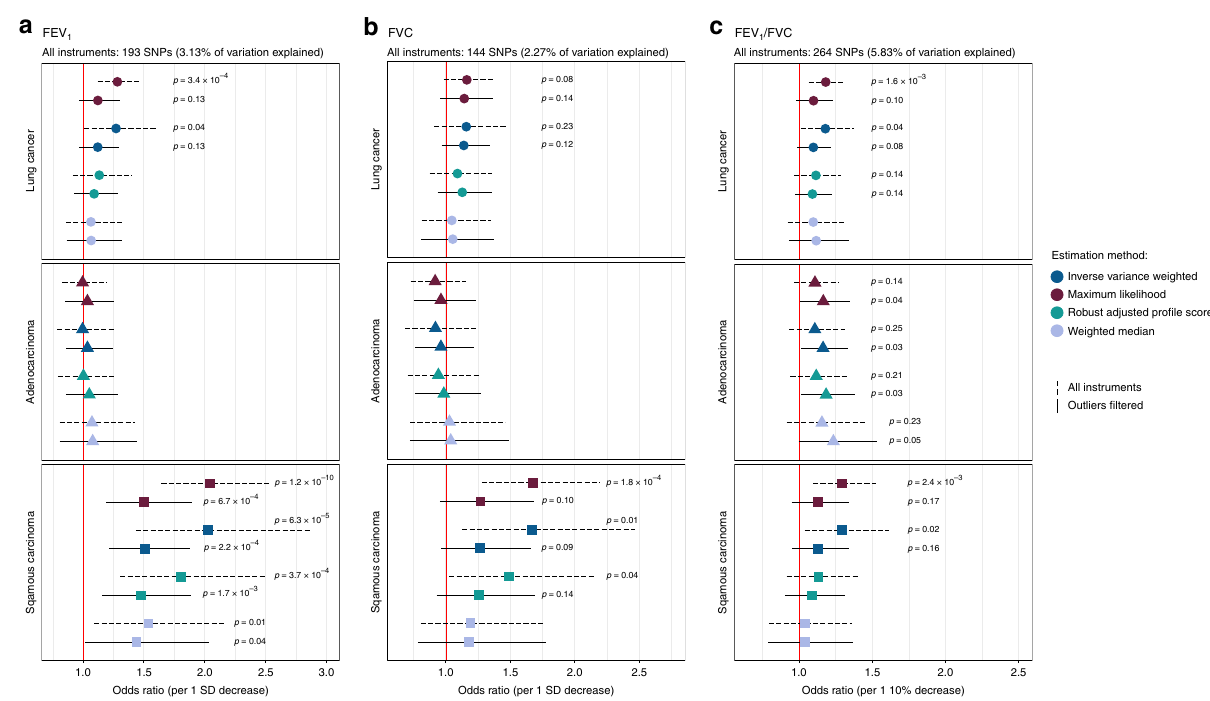
Fig. 4 Odds ratios (OR) and 95% con fi dence intervals for the effect of impaired pulmonary function on lung cancer risk, estimated using Mendelian randomization (MR). Multiple MR estimation methods were applied to the International Lung Cancer Consortium OncoArray dataset, comprised of 29,266 lung cancer cases (11,273 adenocarcinoma, 7426 squamous cell carcinoma) and 56,450 controls to assess the causal relevance of impaired FEV 1 ( a ), FVC ( b ), and FEV 1 /FVC ( c ). MR estimates based on the full set of genetic instruments are compared to estimates after excluding outliers suspected of violating MR assumptions. Only associations with p -values < 0.25 are labeled. Proportion of variation explained by the genetic instruments was estimated in a separate replication sample of over 110,000 individuals from the UK Biobank.